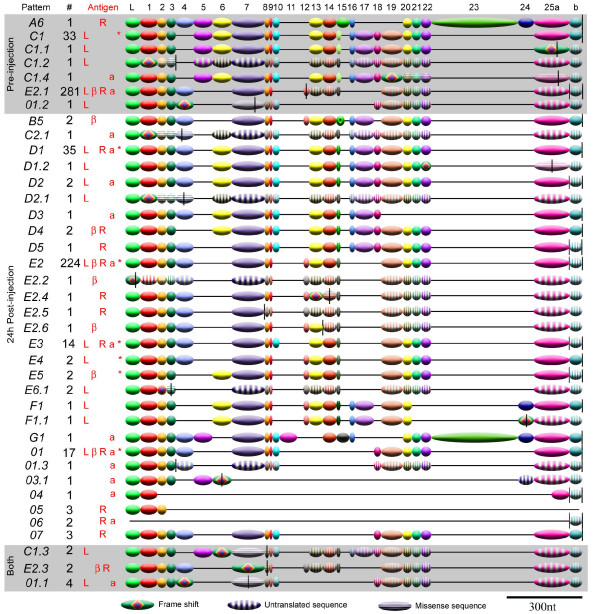
Element patterns identified from sequences of the 185/333 amplicons. The element patterns (defined in [31]) for all of the clones isolated from this study are represented in graphical form. Different elements are shown as differently colored circles and ovals. Gaps are shown as horizontal lines. Short vertical black lines indicate the position of a stop codon and cDNAs with an early stop codon are designated by a decimal point followed by an integer. Elements with a diamond indicate the locations of indels that lead to a frame shift and missense amino acid sequence (elements with horizontal stripes). The sequences located 3' of the stop codon are shown to indicate that the remainder of the transcript sequence is present even though it may not be translated (vertical stripes). The frequency with which each pattern was identified (#) and the antigen that induced the pattern (Antigen) are indicated; L: LPS; β: Lam; R: dsRNA; a: aCF; *: whole bacterial challenge as identified in [31].